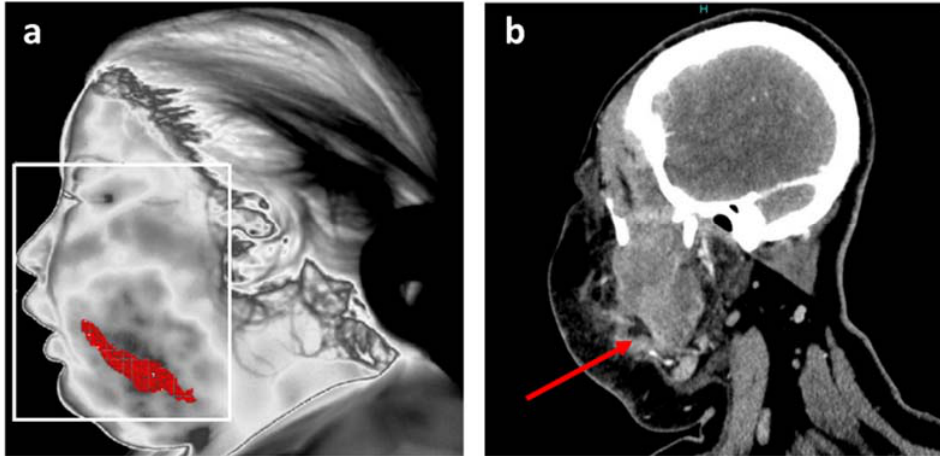
Figure 3. Position of the main inflammation site after thermal analysis for patient 1. ( a ) Resulting accurate localization of main inflammation linked to facial cellulitis with MIT; ( b ) Coronal plane of CT scan in soft tissue window at the level of the infectious collection (red arrow). Patient 2